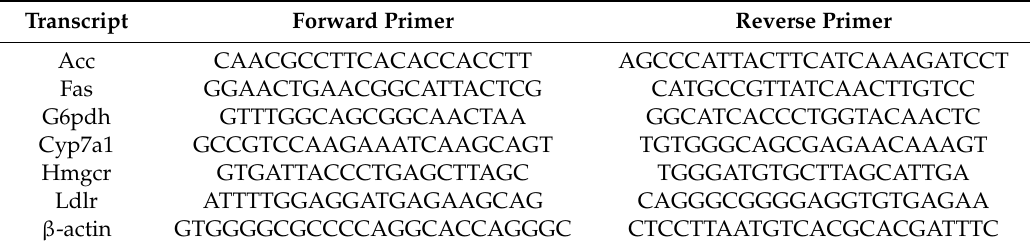
Table 2. RT-PCR primer sequences (5 (cid:48) to 3 (cid:48)